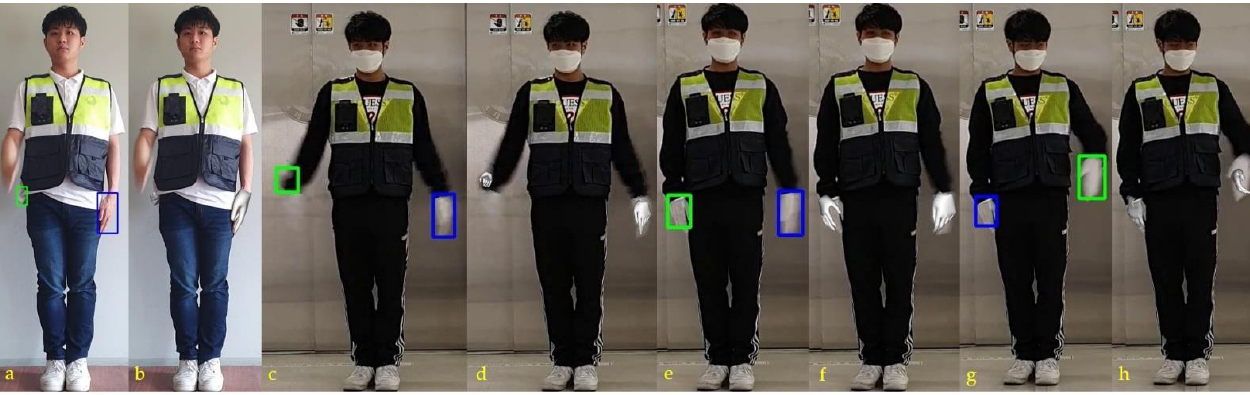
Figure 12. Several examples illustrating errors in the recognition of frames. Here, ( a , c , e , g ) represent hand detection, ( b , d , f , h ) represent the corresponding 3D hand modeling.